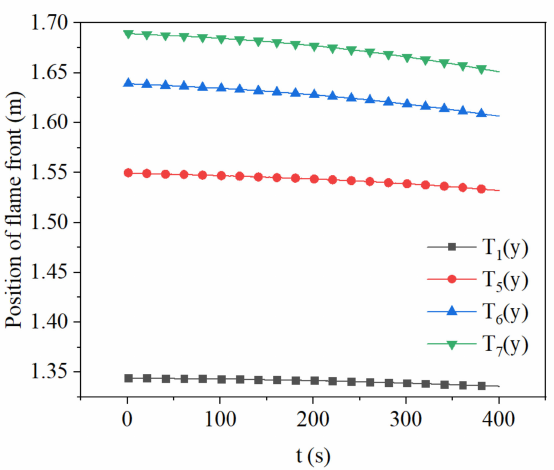
Figure 27. Change of flame front position with time at different widths of high-temperature zone with the inlet flow rate of 700 m 3 /h, X CH